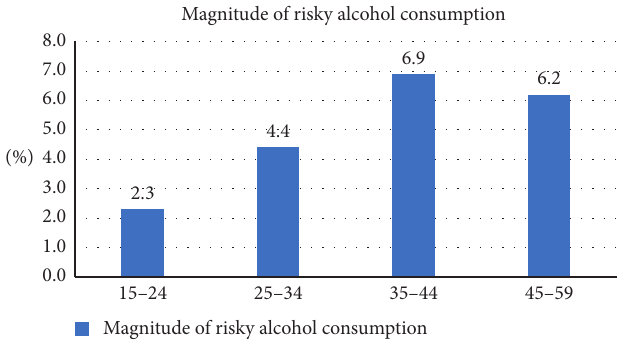
Figure 2: The magnitude of risky alcohol drinking patterns among men by age group, Ethiopia. Table 2: Association of educational attainment and wealth index with risky alcohol drinking pattern among adult men in Ethiopia, ( N �